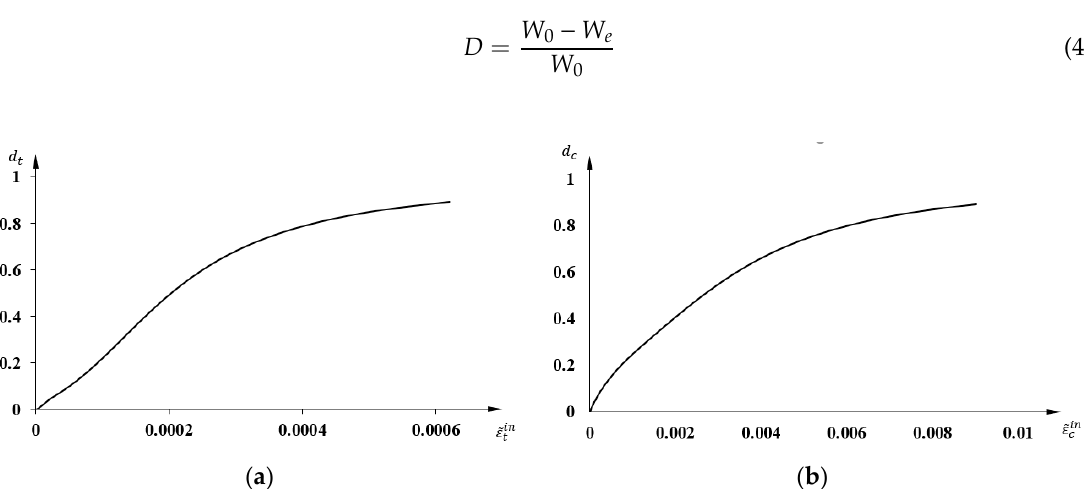
Figure 2. ( a ) The tensile stress-strain relationship of concrete; ( b ) the compressive stress-strain relationship of concrete.